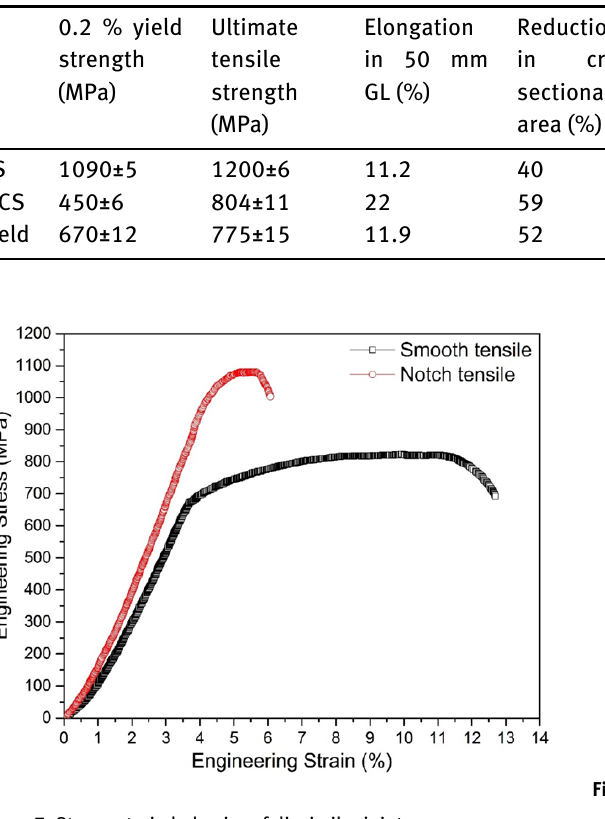
Figure 7: Stress-strain behavior of dissimilar joint.